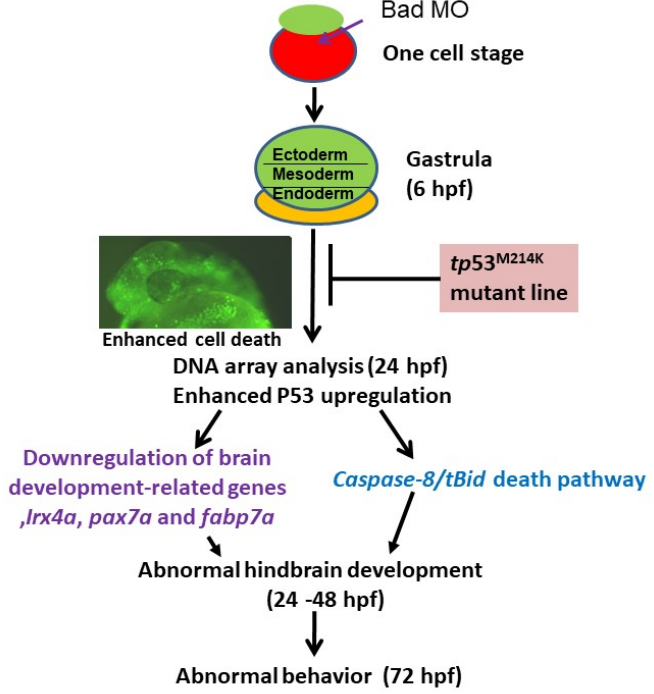
Figure 8. Diagram of Bad’s involvement in committed PCD and brain development from 0.5 to 72 hpf. Early (5.4–12 hpf) PCD is essential for smooth early cell migration and for the formation of the 3 germ layers in later development, which is connected to late (after 12 hpf) PCD for tissue and organ development. Bad ‐ mediated cell death is required for reducing environmental stress, which is correlated with triggering P53 ‐ mediated stress signaling on the p53/caspase ‐ 8/tBid death pathway and suppression of brain development genes such as irx4a , pax7a , and fabp7a , which are correlated with action behavior. Furthermore, Bad ‐ mediated brain defects should be rescued in the tumor ‐ suppressor p53 mutant ( P53 M214K ) line. This model system may be a better system for human brain diseases such as autism, psychoses, cognitive disorders, and XLID in that they are correlated with Bad